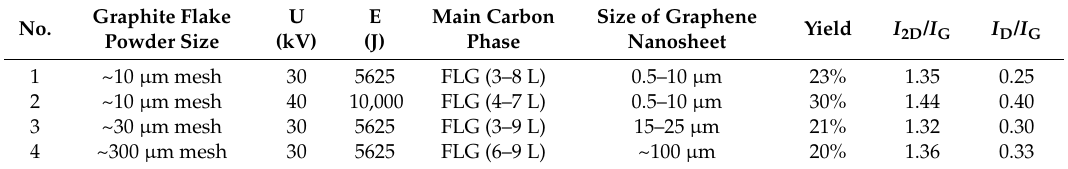
Figure 1. Illustrated diagram of pulsed discharge in graphite micro-flake suspension. 1—stainless steel chamber, 2—lid, 3—insulation pipe, 4—electrodes, 5—plastic pipe, 6—insulation block, 7—graphite micro-flake suspension. Table 1. The experimental conditions of liquid pulsed discharge and characterization results of the recovered samples *.